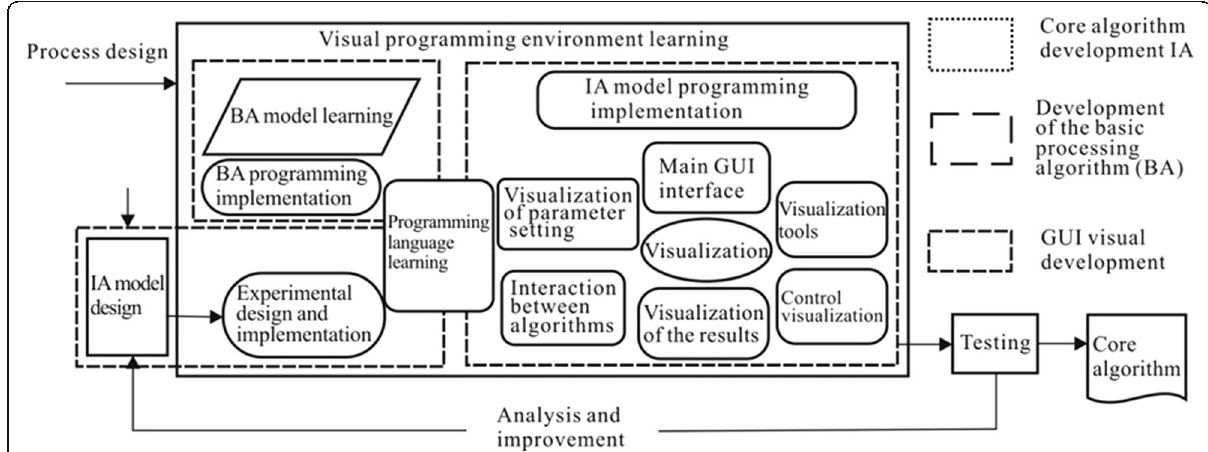
Fig. 2 Model for the research and development process of the image processing